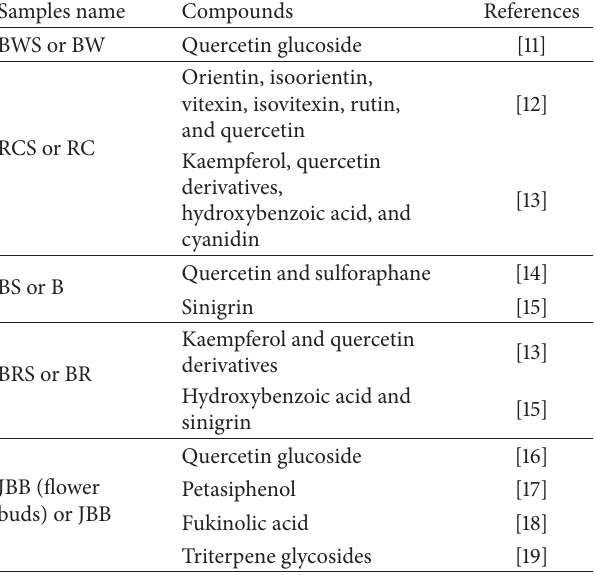
Table 2: Bioactive compounds of sprouts or matured plants. We selected five plant sprouts (buckwheat (BW) sprout (BWS), red cabbage (RC) sprout (RCS), broccoli (B) sprout (BS), brussels (BR)